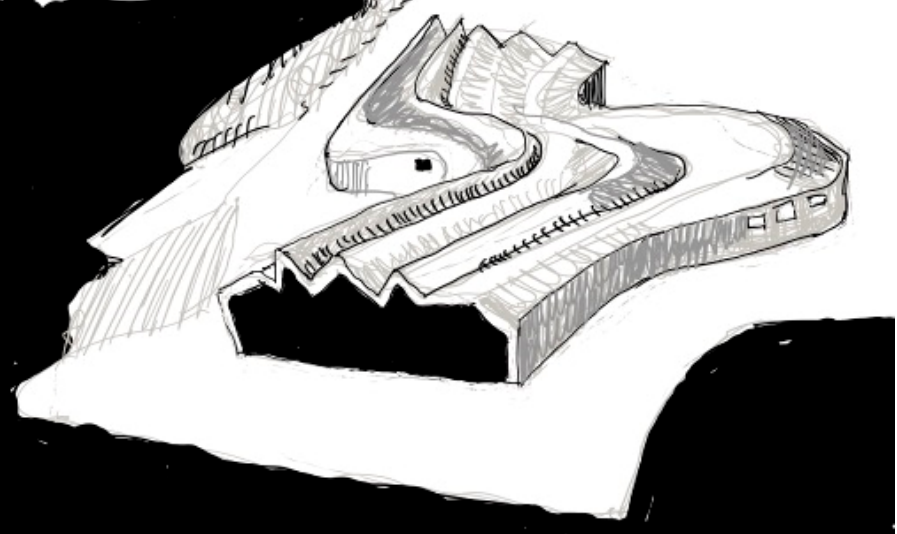
Figure 1. Aerial view of Riverside Museum in Glasgow flanked by water on three sides (Drawing by N.A. Salingaros).